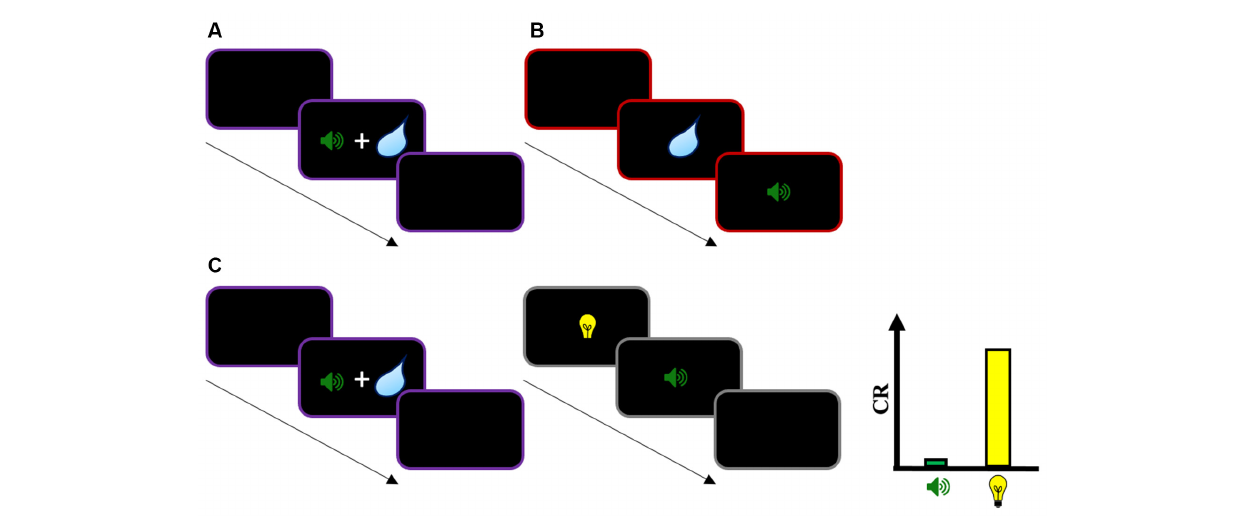
FIGURE 2 | Illustration of simultaneous, backward, and second-order conditioning with simultaneous CS1. (A) Simultaneous conditioning with a stimulus (CS1—sound) presented simultaneously with an unconditioned stimulus (US—water). (B) Backward conditioning with CS1 presented after a US. (C) Second-order conditioning with simultaneous CS1: In phase 1, a stimulus CS1 is presented simultaneously with a US. In phase 2, a second stimulus CS2 is paired with CS1 through forward pairing. During the test, while CS1 will evoke low conditioned response (CR), CS2 will evoke substantial CR. According to the TD account, a low CR evoked by CS1 is expected because CS1 is not followed by the US (i.e., R US = 0) in phase 1. In addition, a change in CS2 value ( V CS2 ) depends directly on CS1’s own value ( V CS1 ). Thus, a second-order pairing with a first-order stimulus CS1 that evokes a low CR level (and with presumably a low predicted value) should result in low responding to CS2. The evidence of substantial response to that stimulus challenges the TD account. The same holds for a model-based account of higher-order learning if the change in V CS2 depends on CS1’s own predicted value V CS1 . Instead, it seems necessary for CS2’s predicted value to be based on US expectations to account for this finding. Note that the same pattern of results is observed for second-order conditioning with backward CS1, and for sensory preconditioning with simultaneous and backward